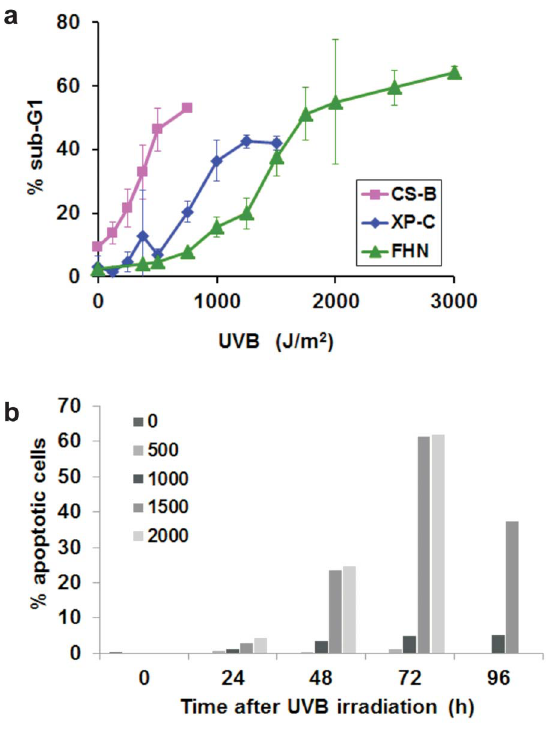
Figure 1. UVB induced apoptosis in FHN, XP-C and CS-B fibroblasts: a) Cells were synchronized in G1, irradiated with steadily increasing doses of UVB, and collected 72 hours after the irradiation. Apoptosis rates were determined by sub-G1 quantification through flow cytometry. b) Cytomorphological analysis of FHN fibroblasts was to determine the percentage of apoptotic cells.